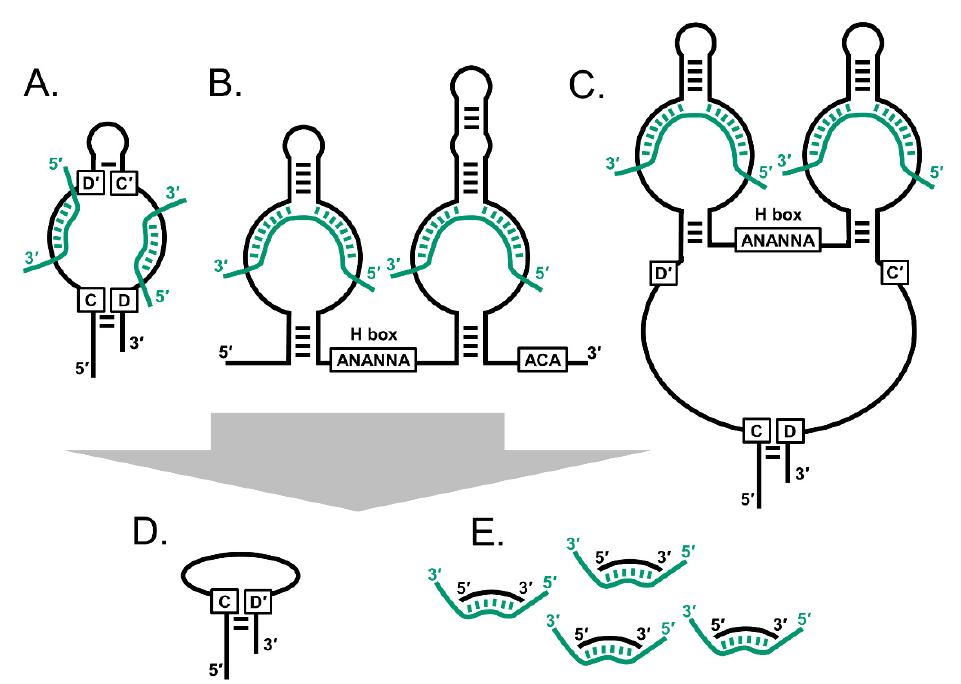
Figure 1. The snoRNAs are an interrelated family of small non-coding RNA. ( A ) C/D box snoRNAs (SNORDs) typically have two sets of C/D boxes that mediate hairpin structures. ( B ) H/ACA box snoRNAs (SNORAs) have an H box and ACA motifs. ( C ) Small Cajal body-specific RNAs (SCARNAs) have combinations of the two motif sets. Smaller snoRNA derived species include ( D ) C/D box-like snoRNAs and ( E ) snoRNA-derived RNAs (sdRNAs). Black strands: snoRNA; green strands: rRNA, spliceosomal snRNA and mRNA.